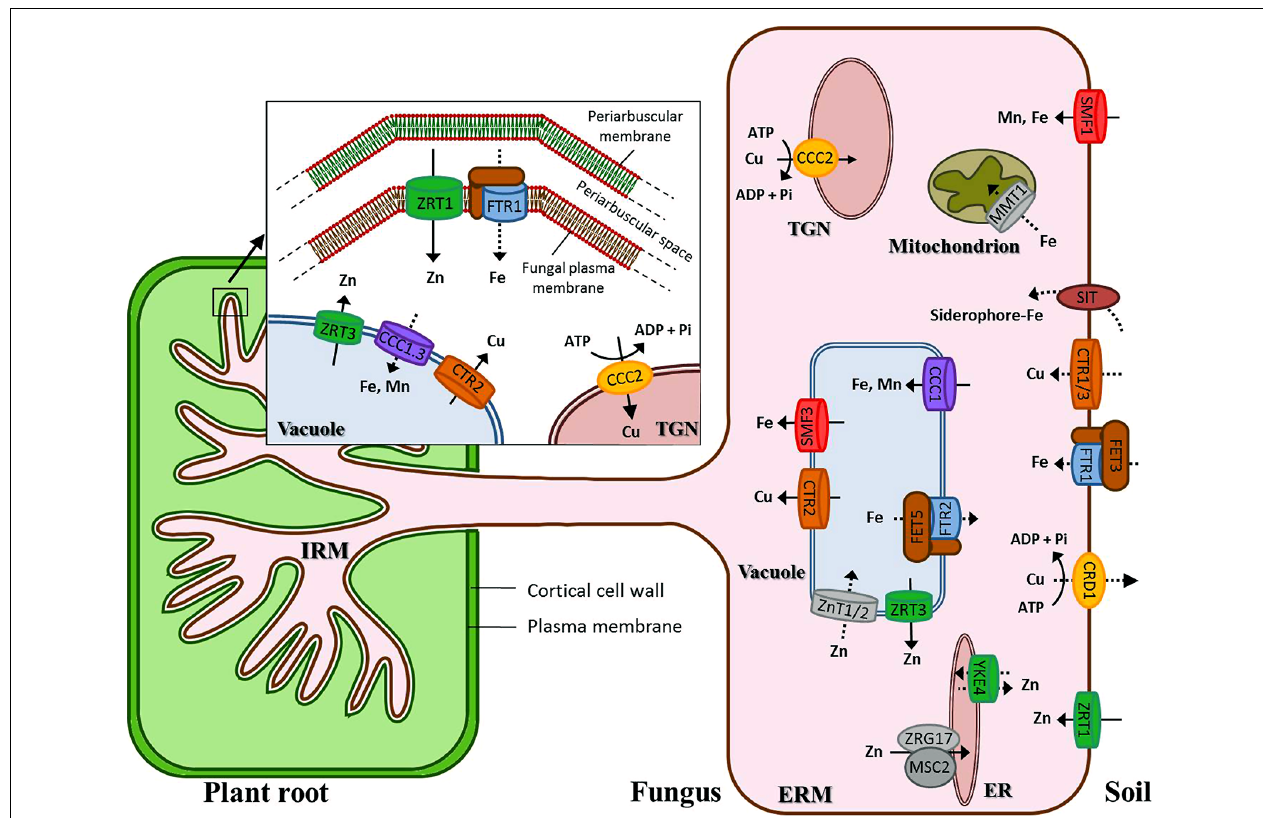
SMF1 that was only up-regulated in the symbiotic roots relative to germinated spores but not to the ERM. Putative Cu transporters (CTR) are in dark orange; P 1B -or Cu-ATPases (CCC2) in light orange; the oxidase-dependent Fe 2 + transporter (OFeT) family members in brown (ferroxidases) and blue (permeases); zinc-iron permeases (ZIPs) in green; cation diffusion facilitators (CDFs) in gray, NRAMPs in red andVITs in purple. ER, endoplasmic reticulum;TGN, trans-Golgi